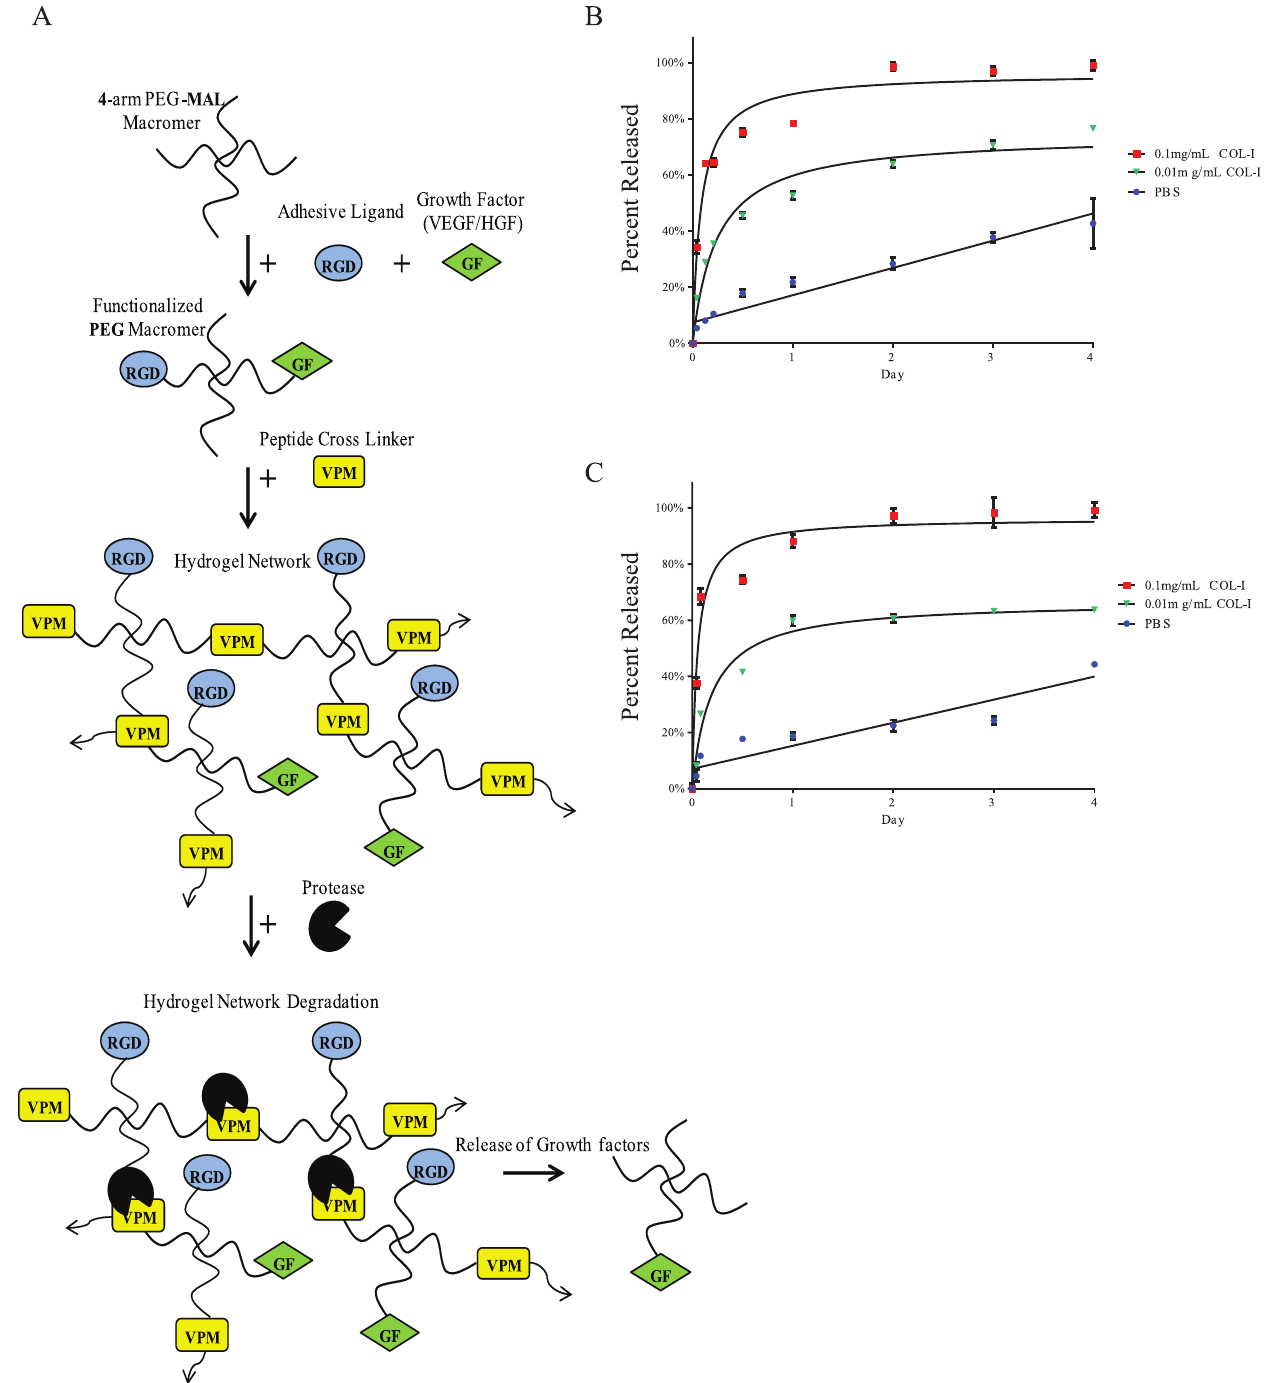
Figure 1. Hydrogel design and release studies. A) PEG-maleimide (PEG-MAL) 4-arm macromers were pre-functionalized with RGD adhesion peptide and growth factors HGF and/or VEGF. The precursor molecules were cross-linked into a hydrogel by addition of cysteine-flanked protease- degradable peptide sequence GCRDVPMSMRGGDRCG (VPM). B) Fluorescently tagged VEGF and C) HGF released from PEG-MAL hydrogel treated with either PBS or 2 doses of collagenase Type 1 as measured by fluorescent plate reader sampling of incubation media. One hundred percent of loaded VEGF and HGF were released by day four after collagenase treatment while lower doses of collagenase and PBS released up to 65% and 40%, respectively. Data are mean 6 SEM from 6 samples per condition. Hyperbolic and linear curve fits indicate different release profiles behaviors for collagenase vs. PBS treatment.